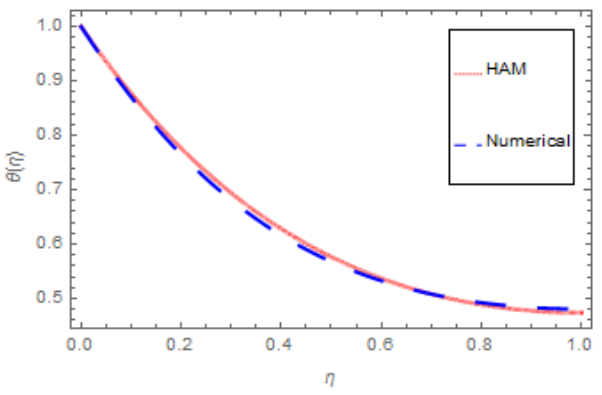
Figure 9. The assessment of HAM and ND-Solve for θ ( η ) . Table 1. The effect of embedded parameters on Cf at 15th order approximations of the homotopy analysis method (HAM).